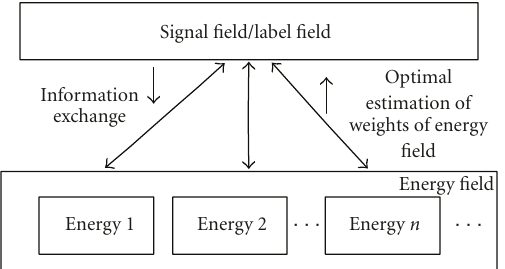
Figure 6: Optimal estimation framework of signals based on turbo iterative.